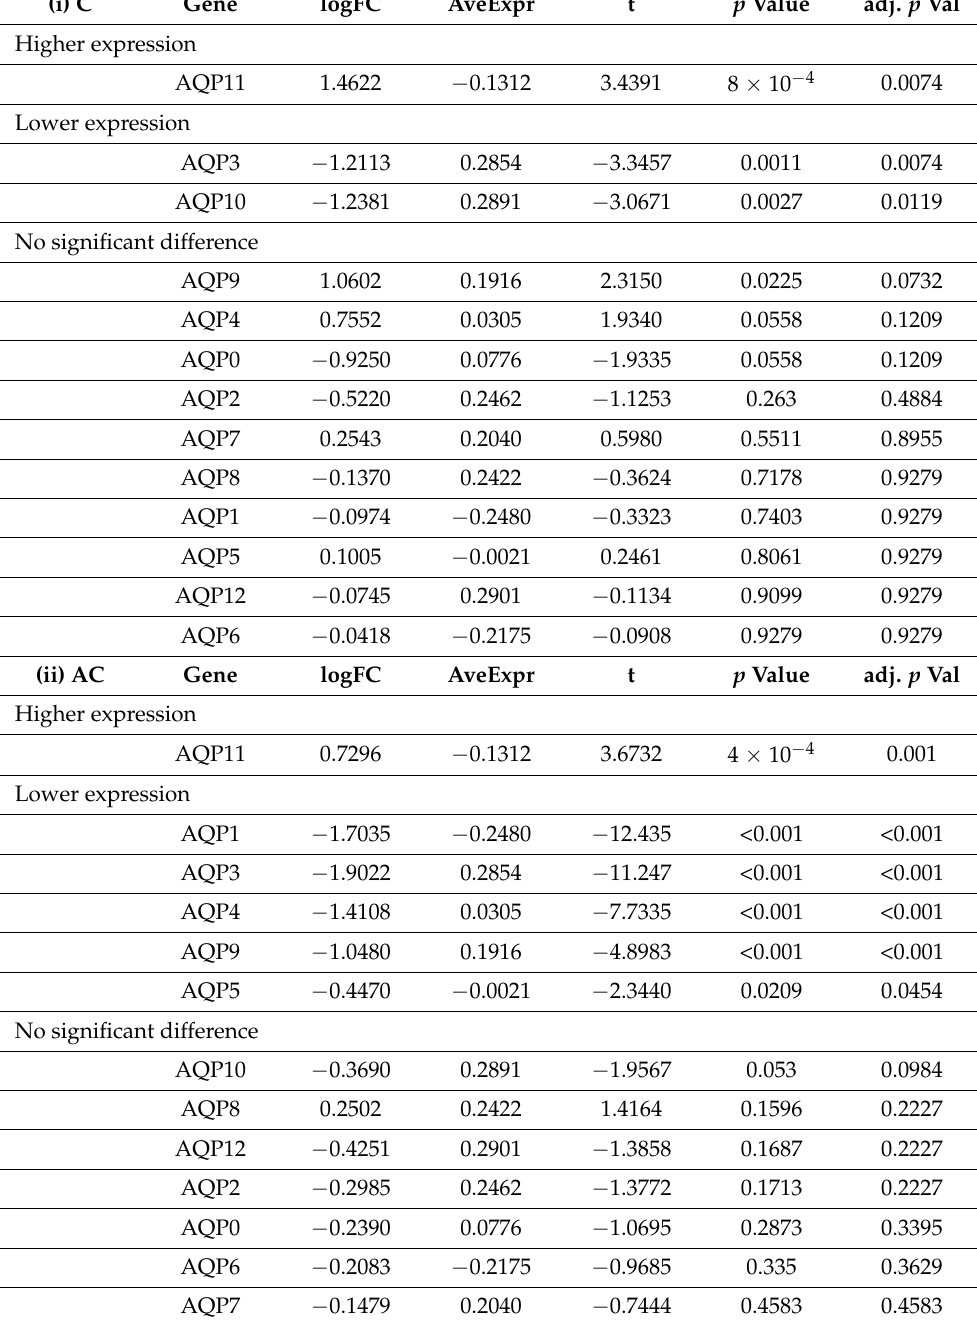
Table 4. Ratios of quantified AQP transcript levels in the temporal cortex as compared to the hippocampal formation differ with age. The average expression (AveExpr) levels were determined by averaging the RNAseq levels for all probes used for a given gene. t -values represent the test statistic associated with the comparison of means using two-sample t -tests, with positive values indicating a larger average RNAseq in the cortical region as compared to the hippocampus. P values were adjusted (Adj P) for multiple tests using the Bonferroni correction, with significant differences indicated by values p < 0.05.